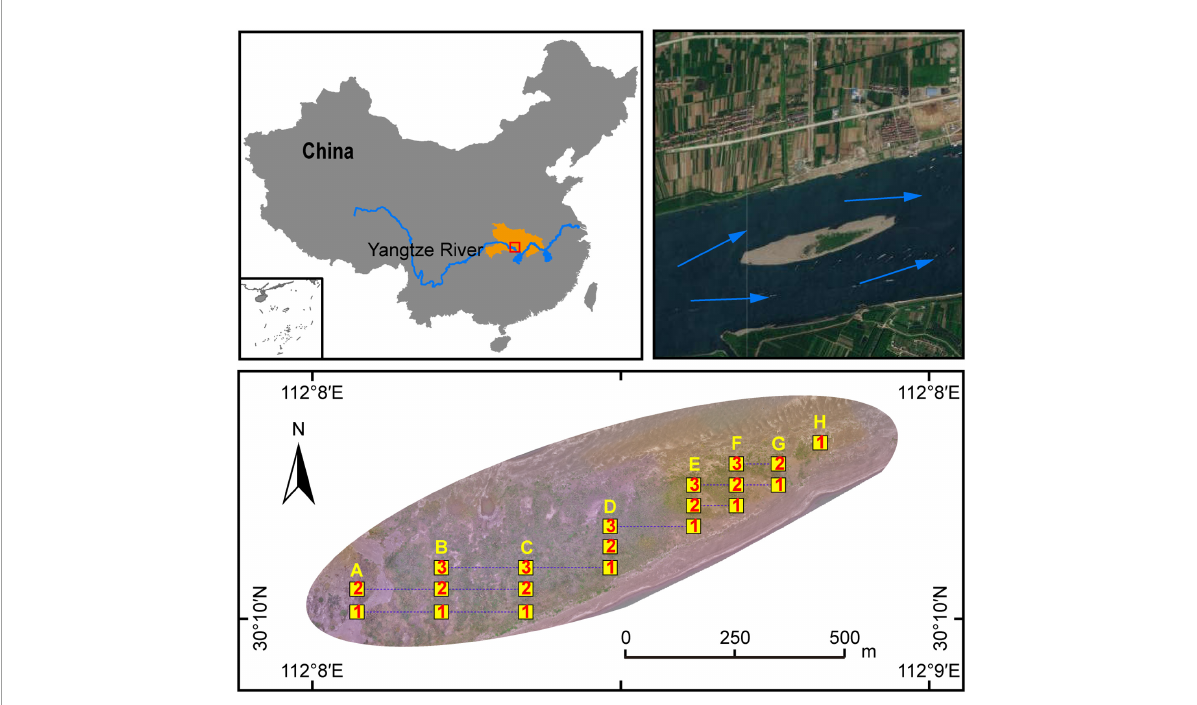
FIGURE1 Schematic diagram of the study site and quadrats distribution in the Taipingkou mid-channel bar (MCB) (30 ◦ 30 (cid:48) N, 112 ◦ 13 (cid:48) E) located at the upper Jingjiang Reach of the Yangtze river. Blue arrows: direction of flow of the Yangtze River. Yellow squares: sampling quadrats. Numbers within yellow squares: the transect in which the quadrat is located. Capital letters above the yellow squares: the longitudinal position of the